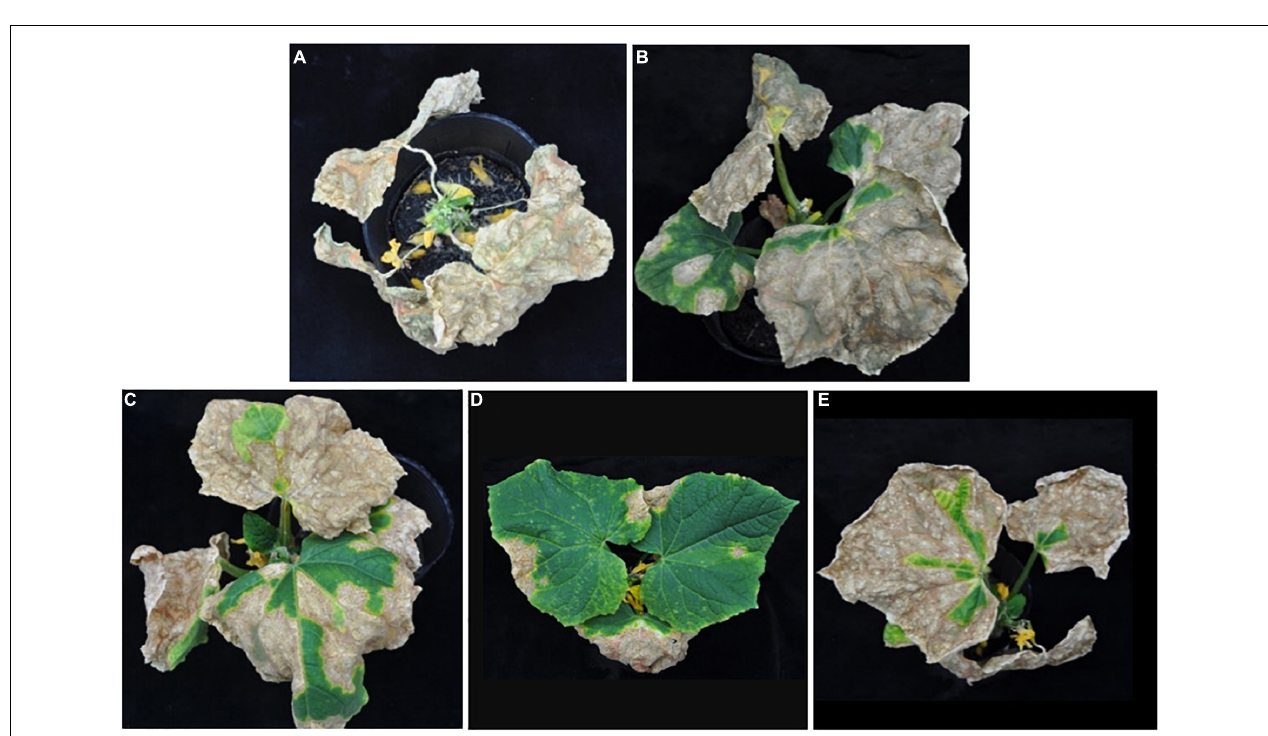
FIGURE 2 | Effect of antagonistic bacterial strains on anthracnose severity of cucumber seedlings 11 days after inoculation. Only one representative plant is shown in each treatment drenched with (A) distilled water as the control, (B) strain TG01, (C) strain TG02, (D) strain LJS06, and (E) strain LJS08.